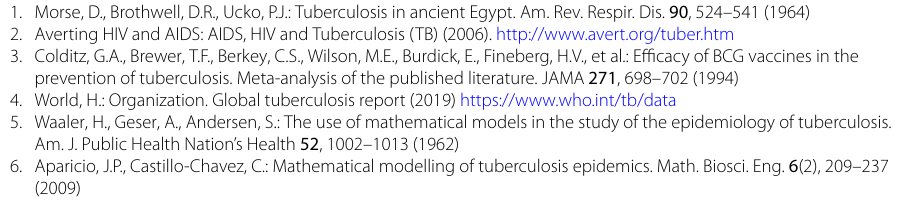
infection. The numerical results also show that decrease in the effective contact rate and increase in treatment coverage can minimize the spread of the TB